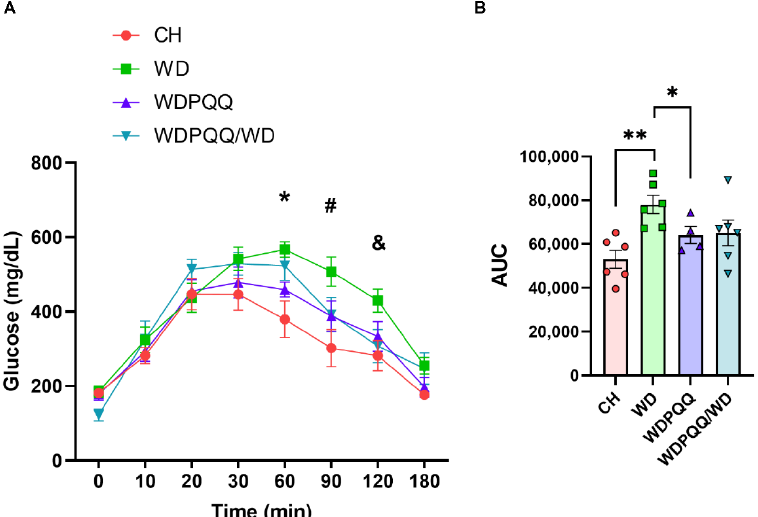
Figure 1. Chronic PQQ supplementation ameliorates WD-induced impaired glucose tolerance in 20 to 24 wk-old offspring. ( A ) Glucose tolerance test (GTT) measurements were obtained at baseline and 10, 20, 30, 60, 90, and 180 min following glucose injection. Data are means ± SEM, n = 4 – 6/group. * p < 0.01 CH and WDPQQ vs. WD; # p < 0.01 CH vs. WD; & p < 0.05 CH and WDPQQ/WD vs. WD using Student’s t test. ( B ) Area under the curve (AUC) from GTT. * p < 0.05, ** p < 0.01 vs. WD using Student’s t test. Data are means ± SEM, n = 4 – 6/group. Int. J. Mol. Sci. 2022 , 23 , x FOR PEER REVIEW